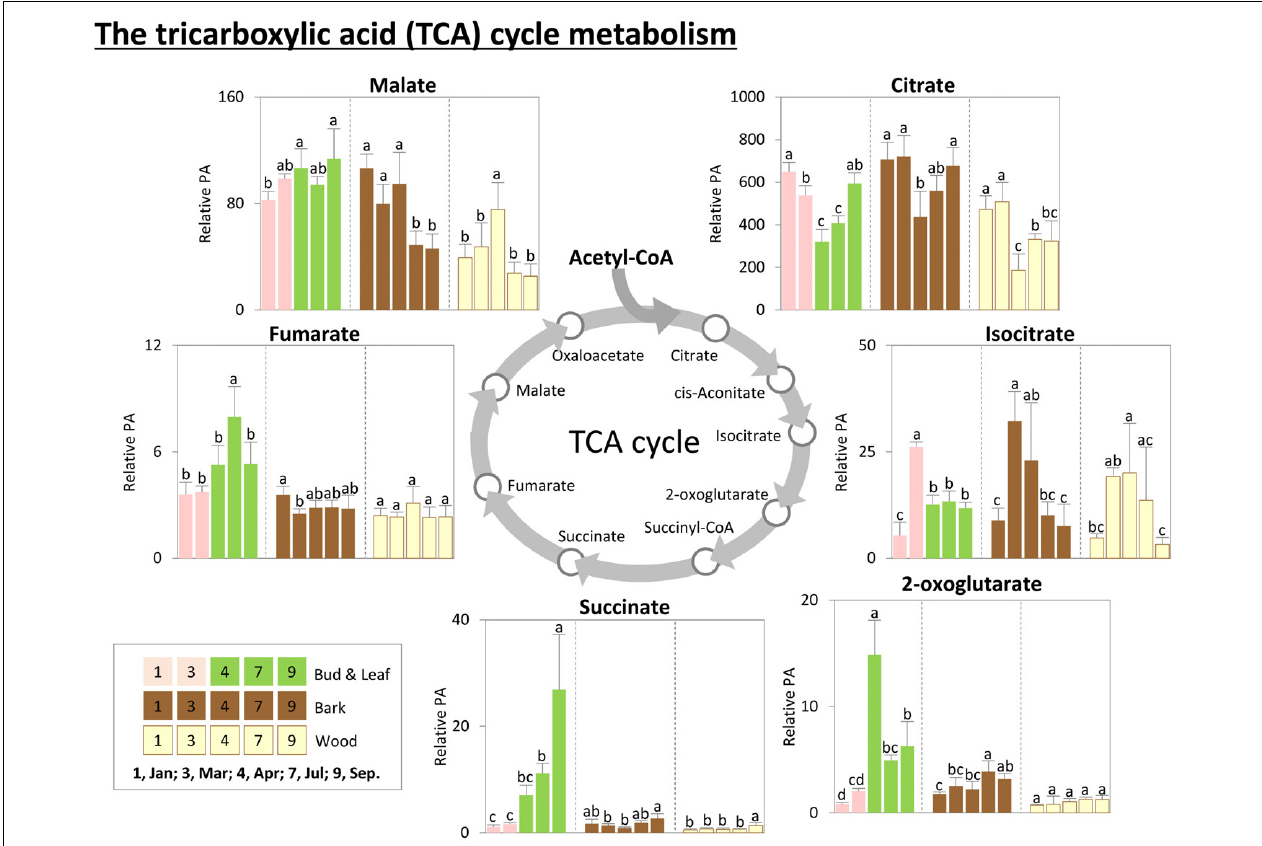
FIGURE 6 | Metabolic changes in the tricarboxylic acid (TCA) cycle metabolism. Changes of the selected metabolites in the TCA cycle metabolism in poplar during annual growth. Data represent mean values of five biological replicates in each organ/tissue for each season. Error bars represent SD. Different letters represent statistically significant differences ( P < 0.05) between seasons in each organ/tissue using Tukey’s test ( Supplementary Table S1 ). Relative PA, relative peak